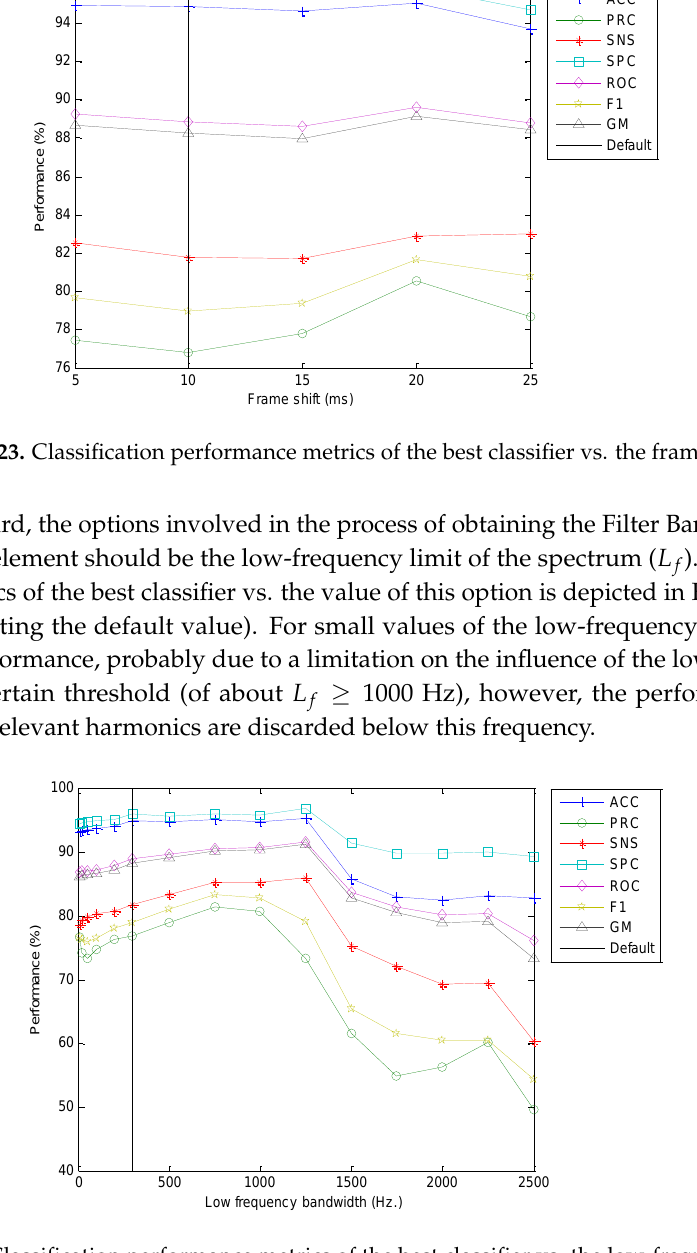
Figure 24. Classification performance metrics of the best classifier vs. the low-frequency limit.